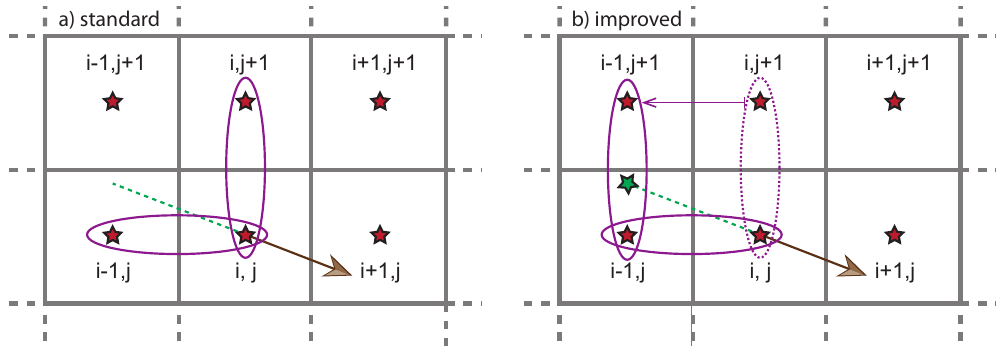
Fig. 3. Two-dimensional view of grid cell i,j with a brown velocity vector pointing to the lower right cell neighbors (0 ≥ v i,j 1x/1y ≥ − u i,j ). The standard first-order upwind scheme takes into account the gradients along the two axes between the direct upstream neighboring cells (a) . In order to gain a higher accuracy the second gradient is shifted upstream (violet arrow) (b) . This improved scheme mimics a velocity-weighted gradient along the green-dashed flow line.